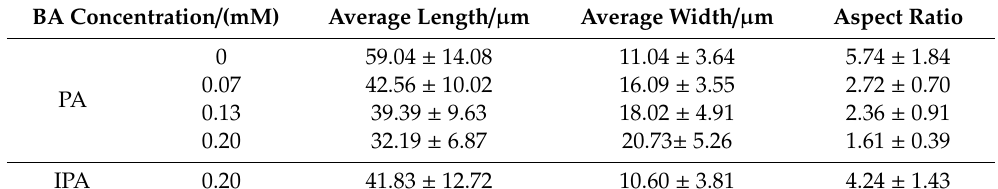
Figure 2. Effect of BA on the crystal habit of CaSO 4 ·0.5H 2 O. ( a ) 0 mM; ( b ) PA: 0.07 mM; ( c ) PA: 0.13 mM; ( d ) PA: 0.20 mM; ( e ) IPA: 0.20 mM; ( f ) TA: 0.20 mM. Table 2. Effect of benzenedicarboxylic acid (BA) on the length, width, and aspect ratio of α- CaSO 4 ·0.5H 2 O particles.